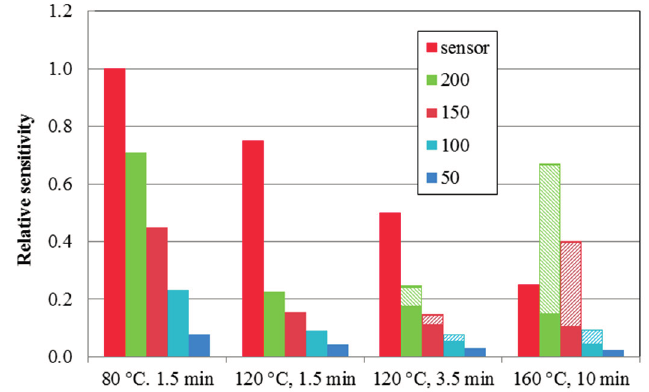
Figure 8. Experimental relative sensitivities for structures from Figure 5 (red columns). Calculated relative active (sensitivity) areas (full columns) and deformation contribution areas (hatched columns)—here marked as “relative sensitivity”. Differently colored columns indicate the contributions below the defined threshold level (“50”—dark blue columns, “100”—light blue columns, “150”—brown columns and “200”—green columns). Note that “255” represents the surface of the SPE